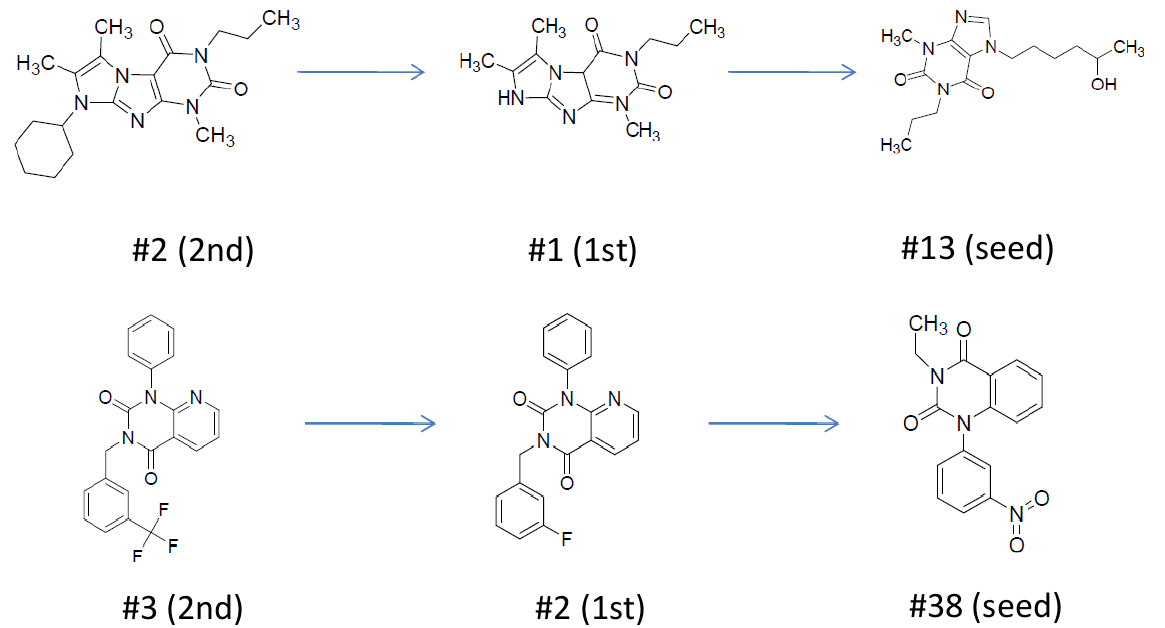
Figure 7. Scaffold hopping and preservation during the 2-step screening cascade in the case of PDE4B inhibitors.